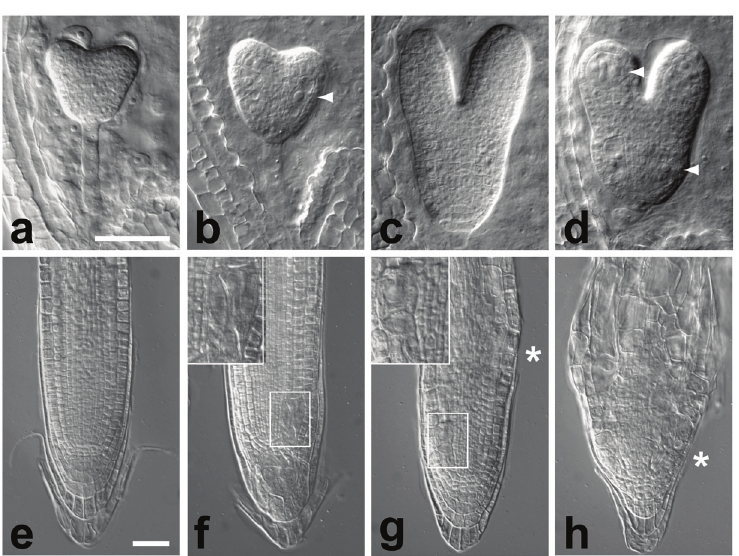
Fig 4. An allelic series of the RSW7 gene. ( a – d ): kn -like phenotype of rsw7-lph / rsw7-1 embryos. Nomarski images of whole mount cleared immature seed containing wild type ( a , c ) and trans-heterozygous embryos ( b , d ) at the early heart ( a , b ) and torpedo stage ( c , d ); arrows point to examples of enlarged cells with polyploid nuclei. ( e – h ): Aberrant divisions in the root meristem of rsw7-1 and rsw7-lph / rsw7-118 seedlings. Nomarski images of wild type ( e ), and rsw7-lph / rsw7-118 trans-heterozygotes ( f ), grown at 25°C; and rsw7-1 grown at 16°C (permissive temperature) ( g ), and 25°C (non-permissive temperature) ( h ); examples of abnormally large cell within the meristem, presumably resulting from a failure of mitosis, are boxed in ( g , h ) and shown magnified (top); stars indicate the boundary between meristem and elongation zone, as marked by the appearance of highly vacuolated rectangular cells. Scale bars equal 50 μ